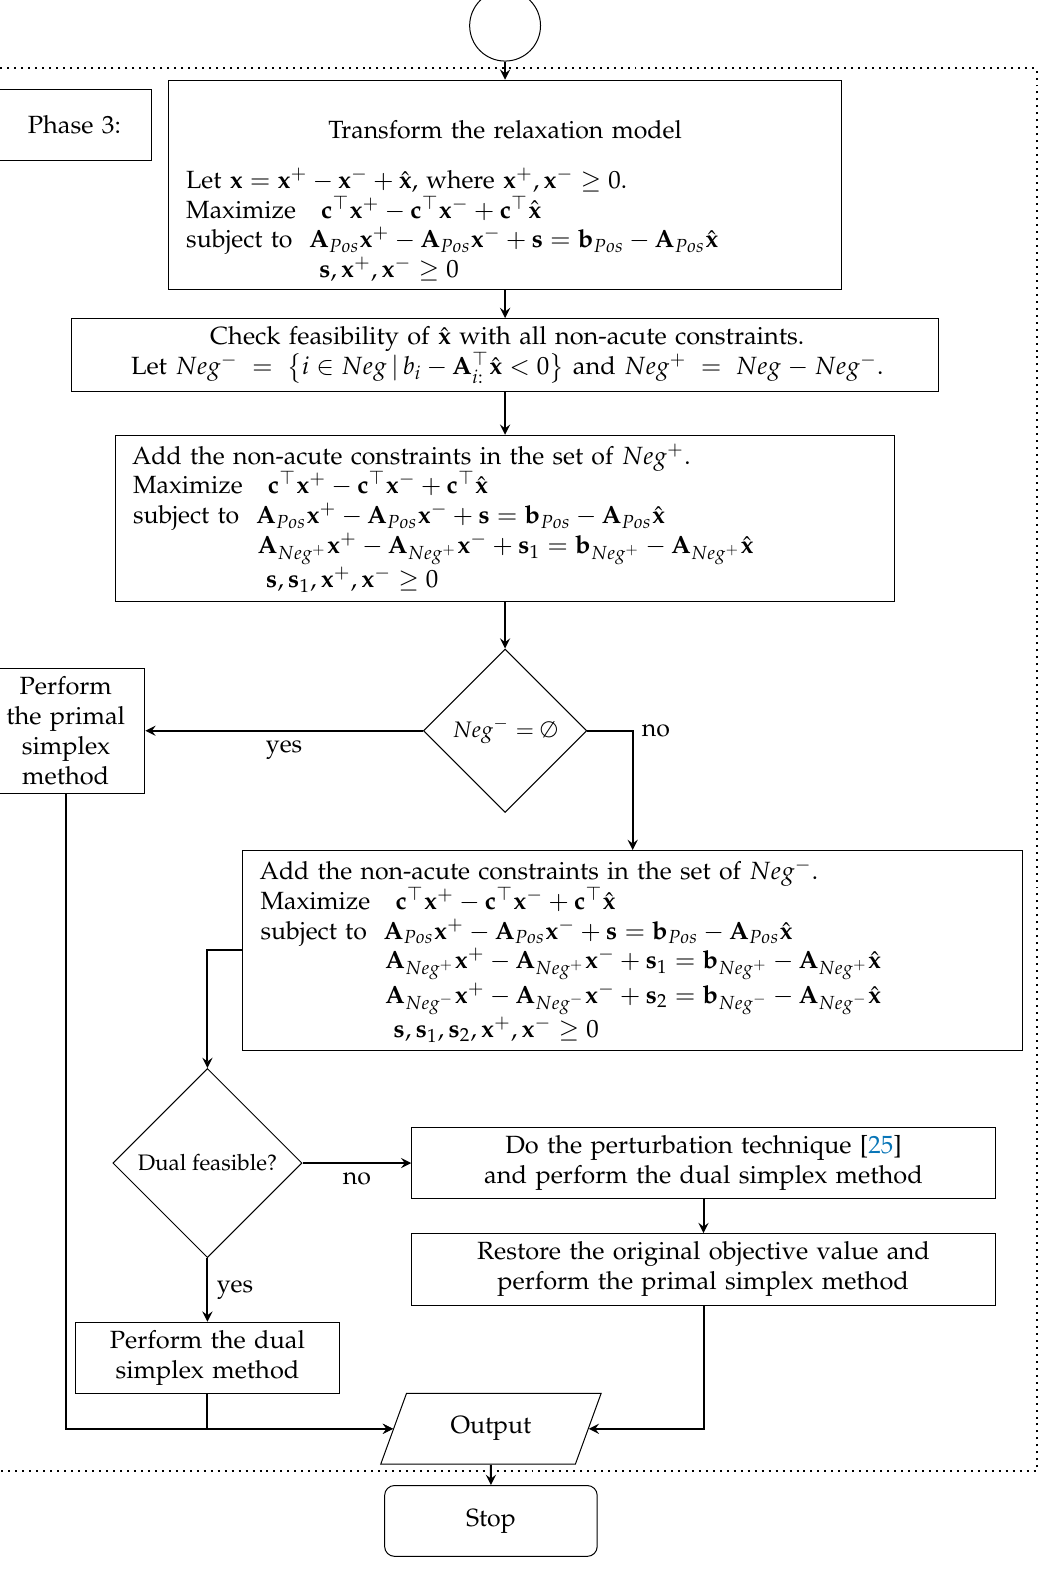
Figure 4. The flowchart of SAJS showing phase